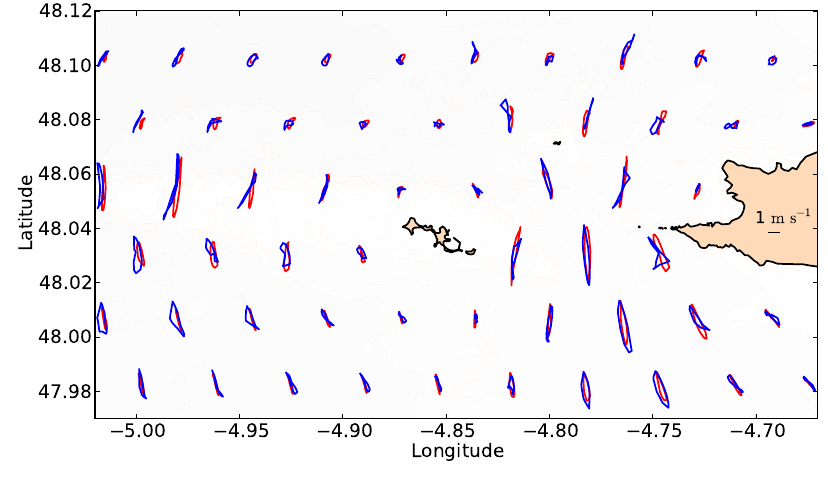
Figure 3. Current ellipses of depth-averaged velocities for mean spring tidal conditions (red) issued from the SHOM (“Service Hydrographique et Océanographique de la Marine”) database [41] and (blue) predicted with TELEMAC